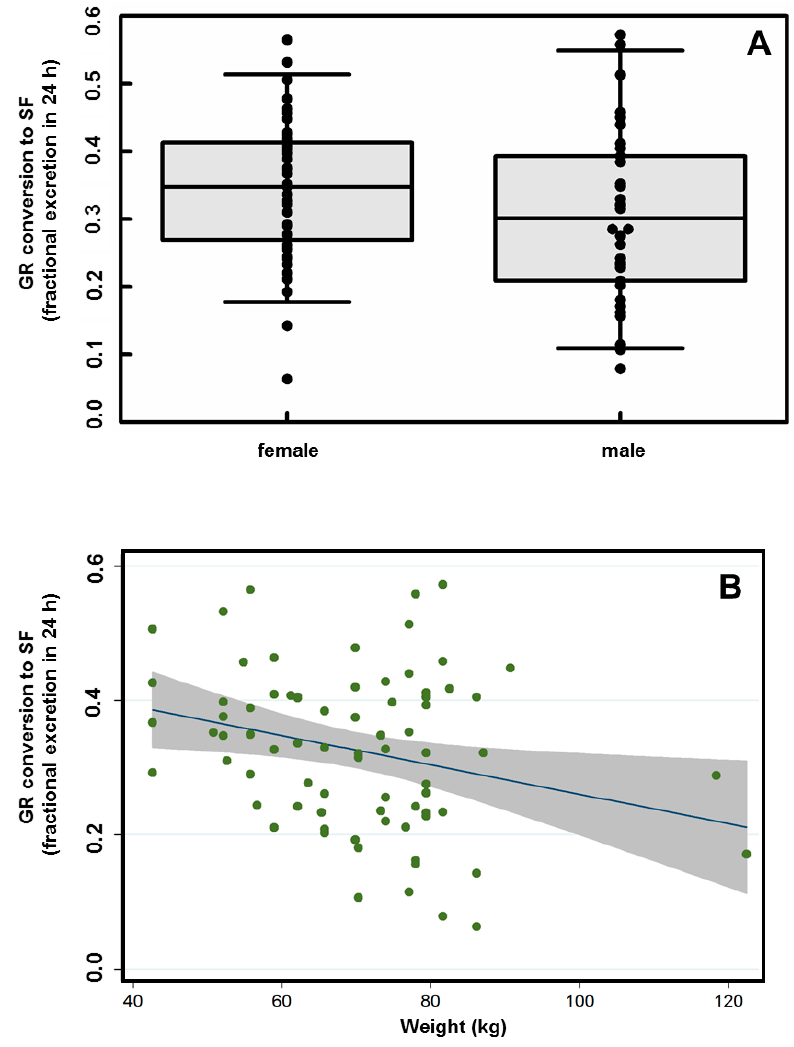
Figure 3. Excretion of SF metabolites following a single oral BSE dose containing GR and active myrosinase. ( A ) Relationship between sex of participant and bioavailability (NSD). ( B ) Relationship between body weight and bioavailability. Shaded region represents 95% C.I. around fitted line (F 1,74 = 5.83, p <